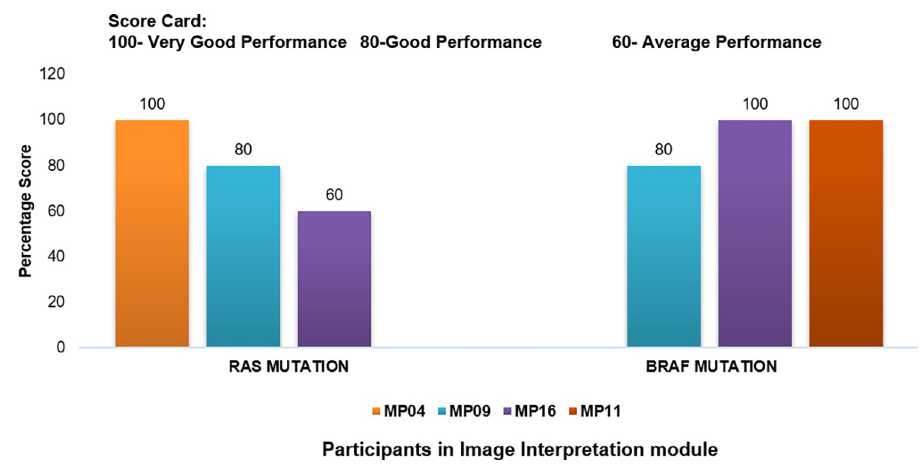
Fig 6. Performance of participants who participated in Digi EQAS module for RAS and BRAF mutations.